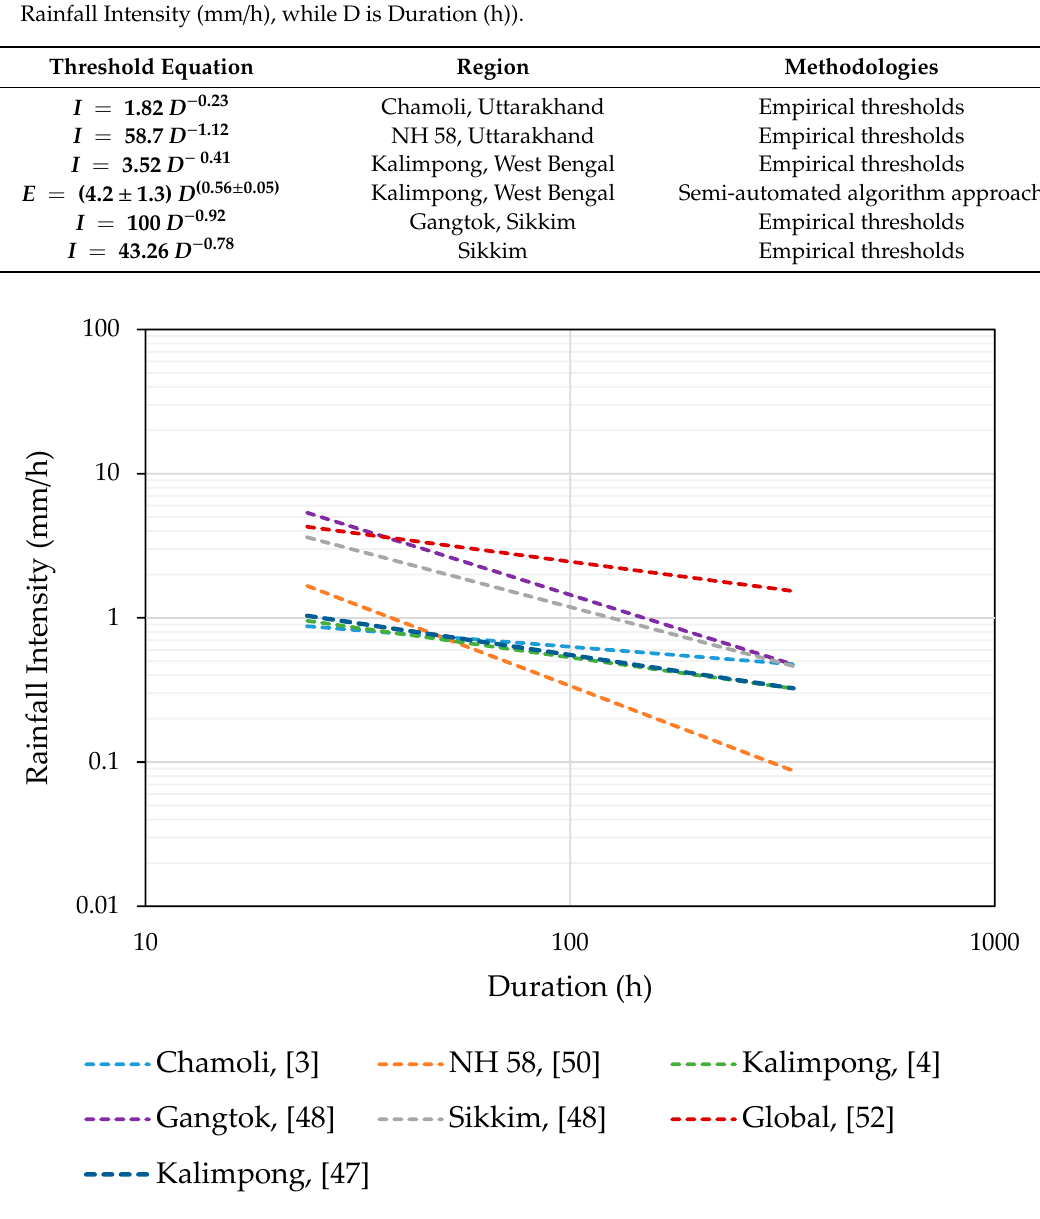
Figure 6. Comparison of various ID thresholds developed for various Himalayan regions with global thresholds defined by Caine [52].